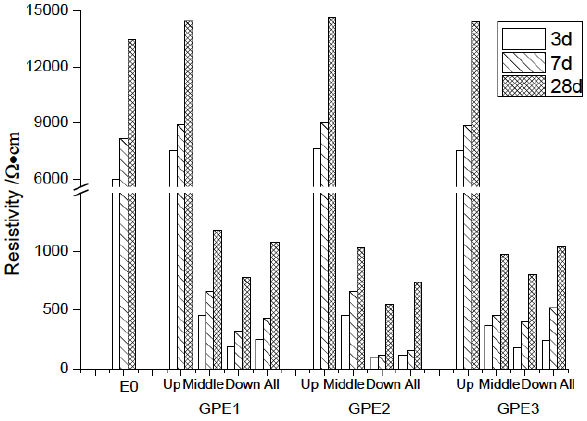
Figure 3: Measured values of resistivity ( Ω · cm)